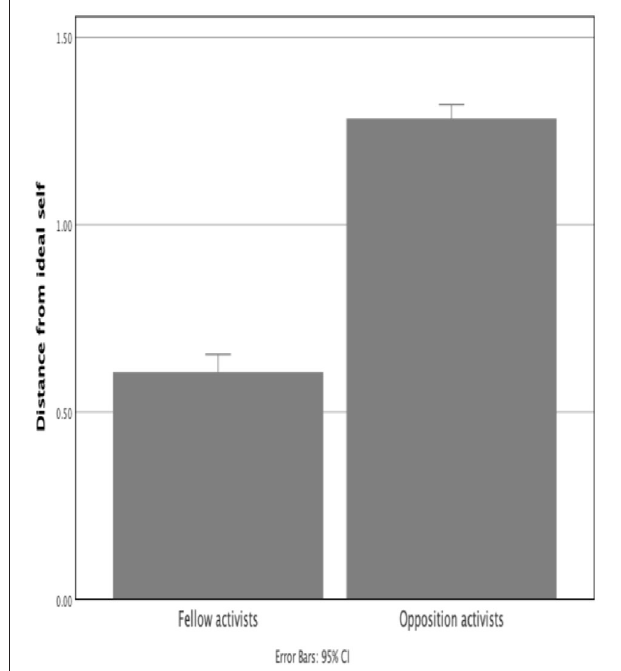
FIGURE 6 | Distance from Ideal Self of fellow and opposition activists (larger distances indicate a more negative construing). Correlation of